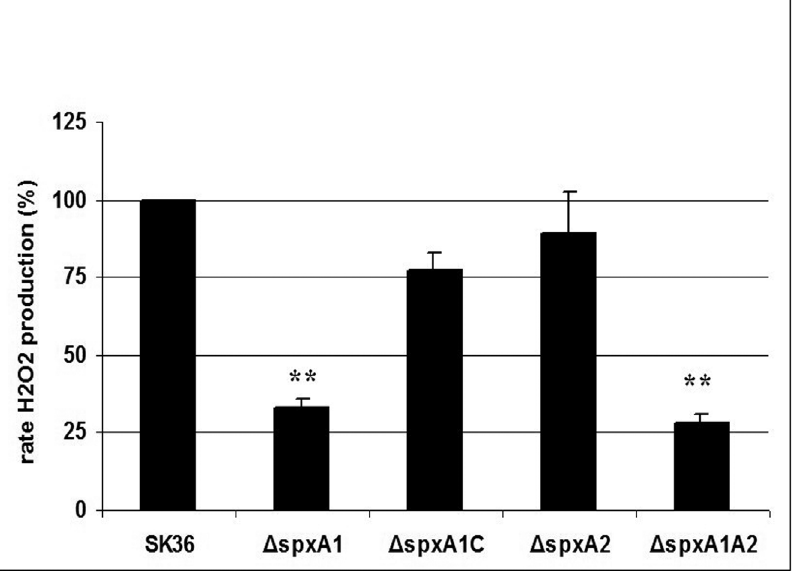
Figure 1. H 2 O 2 production in S.sanguinis strains. H 2 O 2 production normalized to culture densities was determined relative to that produced by the wild type strain SK36. Results are expressed as the mean of percentage values relative to the wild-type strain SK36 from three biological repeats. Statistical significance is indicated (** P , 0.01).